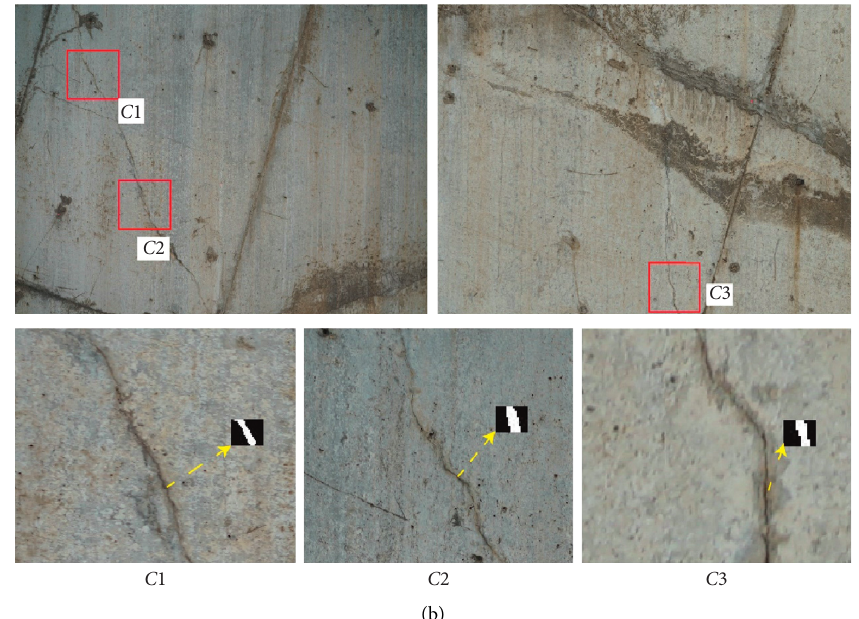
Figure 17: Bridge inspection images based on UAV. (a) Long-distance image of bridge crack and (b) close-distance image of bridge crack.